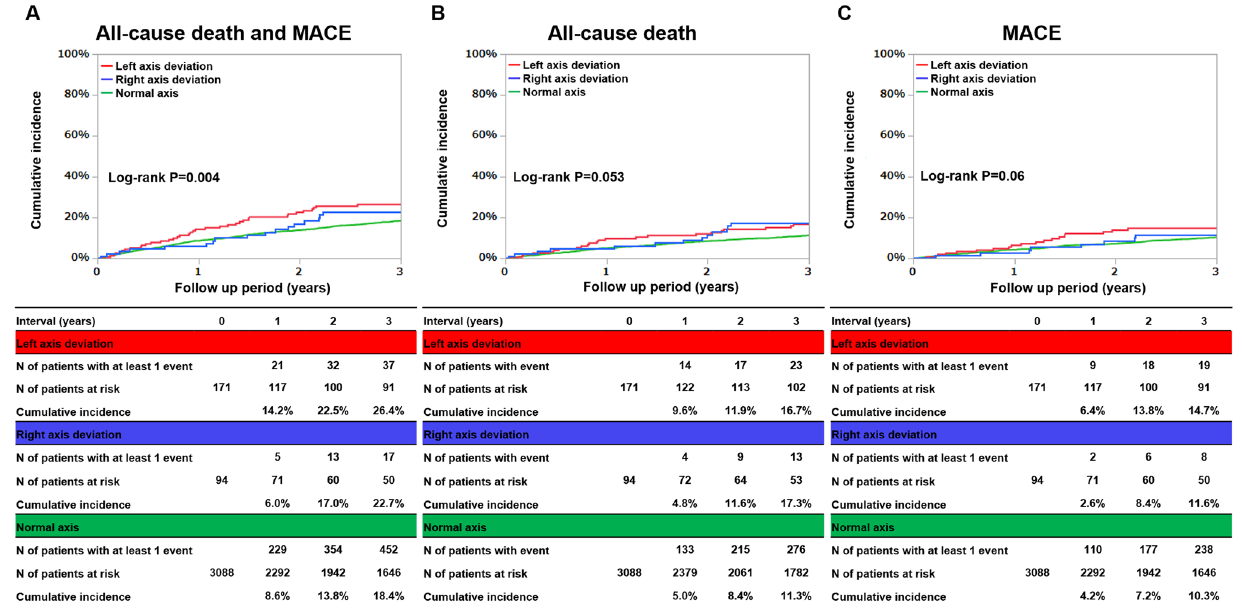
Figure 2. Cumulative incidence of the primary outcome measure (a composite of all-cause death and MACE) and secondary outcomes measure (all-cause death, MACE). ( A ) A composite of all-cause death and MACE, ( B ) all-cause death, ( C ) MACE. MACE major adverse cardiovascular events. Left axis deviation N of patients